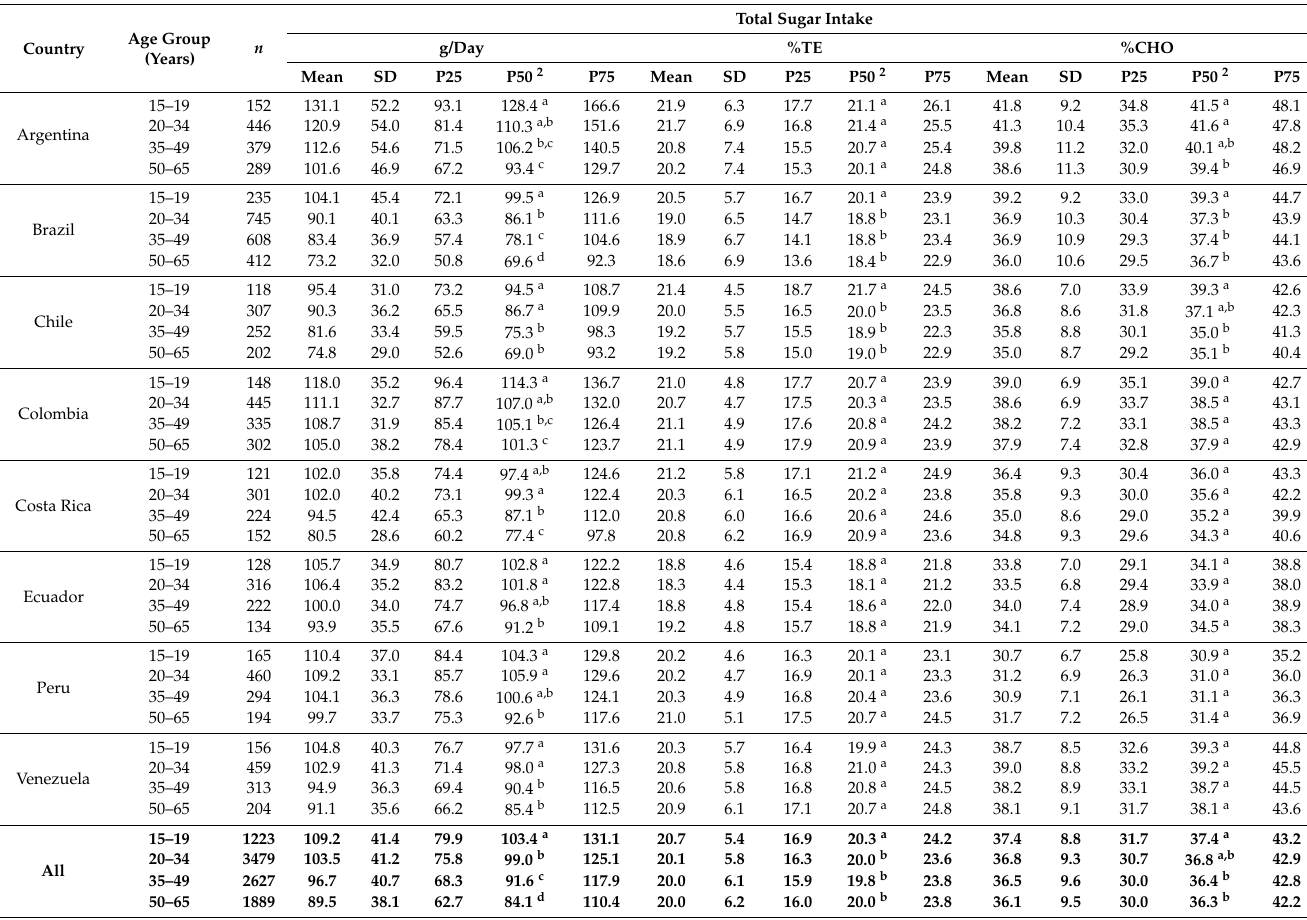
Table 7. Total sugar intakes 1 in individuals residing in urban areas of Latin American countries, according to age groups; Latin American Health and Nutrition Study (ELANS),